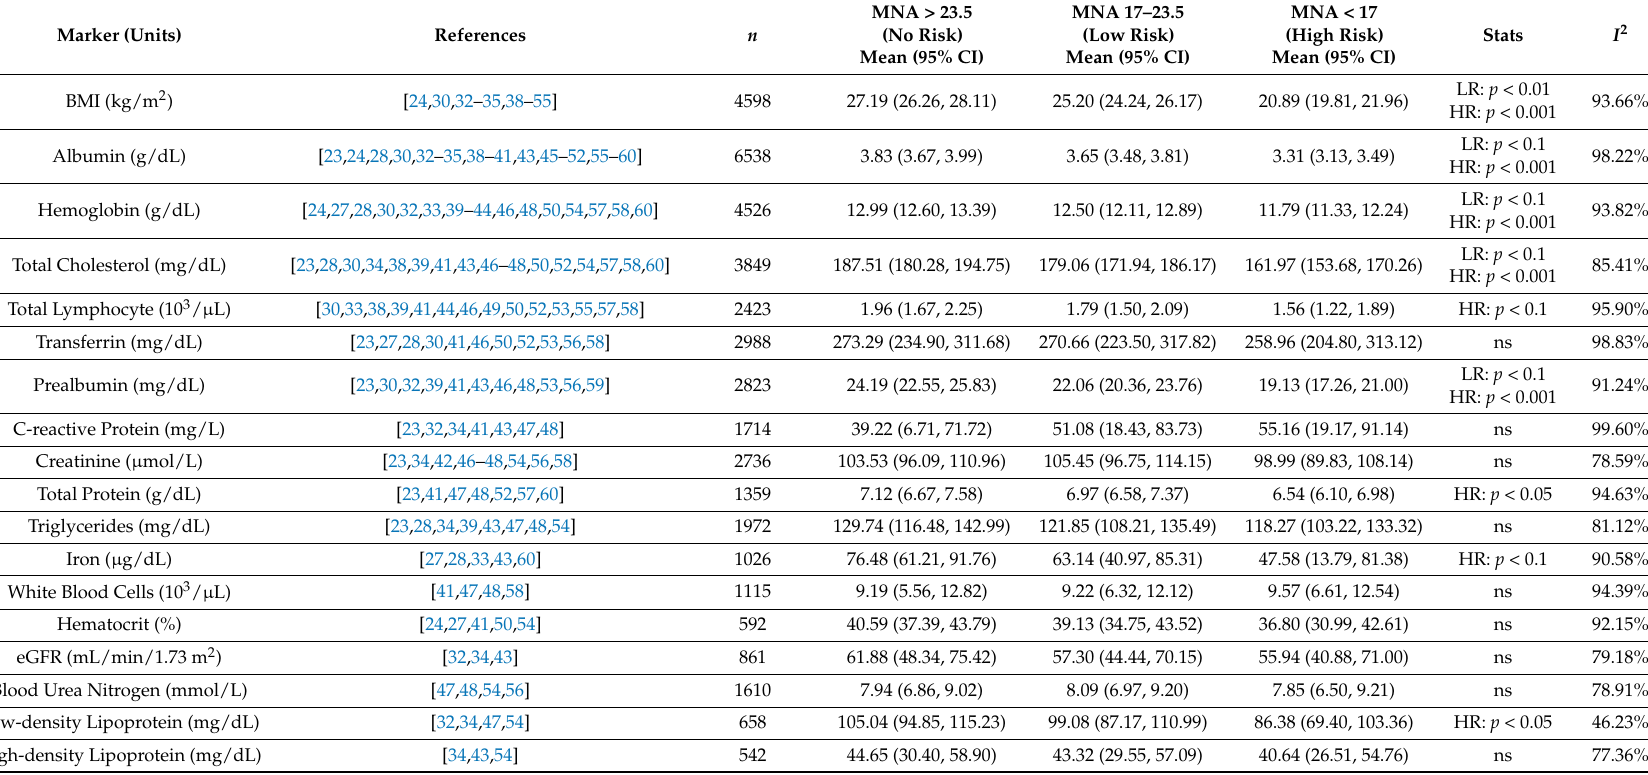
Table 1. Mean biomarker levels in 3 subgroups of malnutrition risk status defined by MNA, excluded patients with acute disease 1